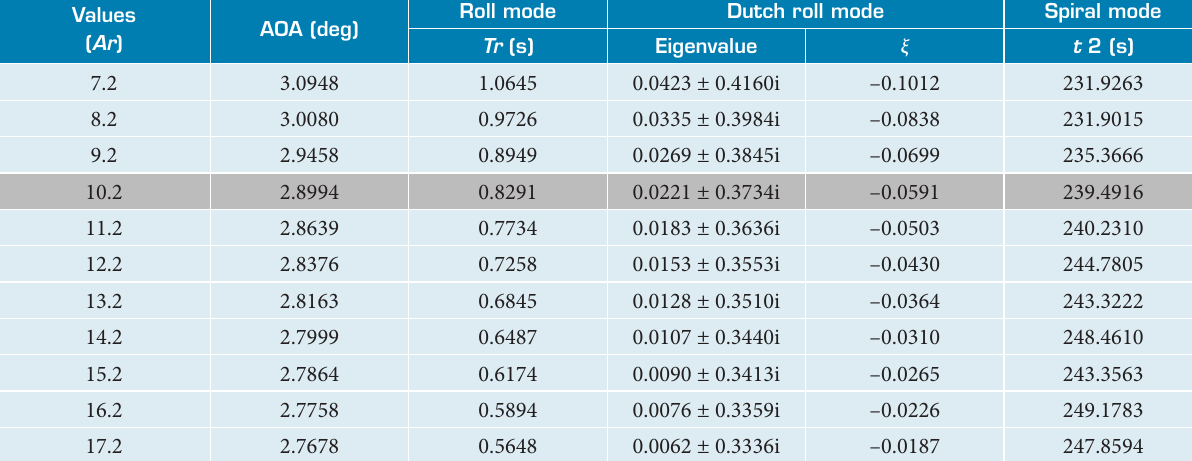
Table 3. Influence of Ar on lateral-directional